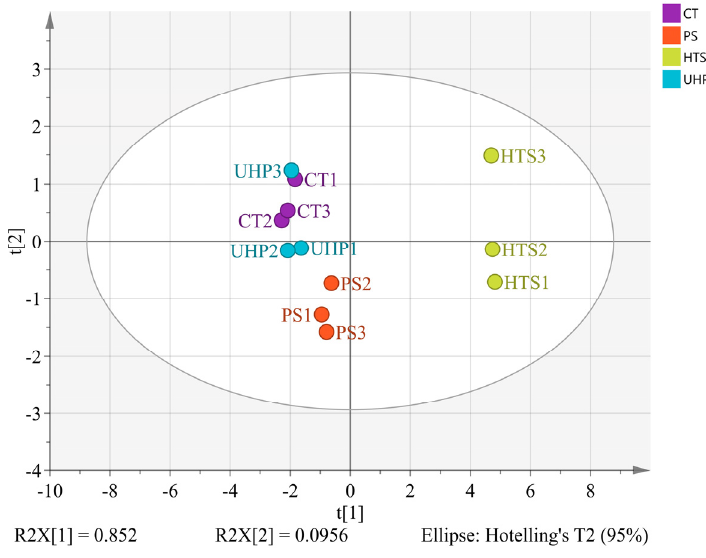
Figure 3. PCA bi − plot of sauces generated from electronic nose data ( p < 0.05).